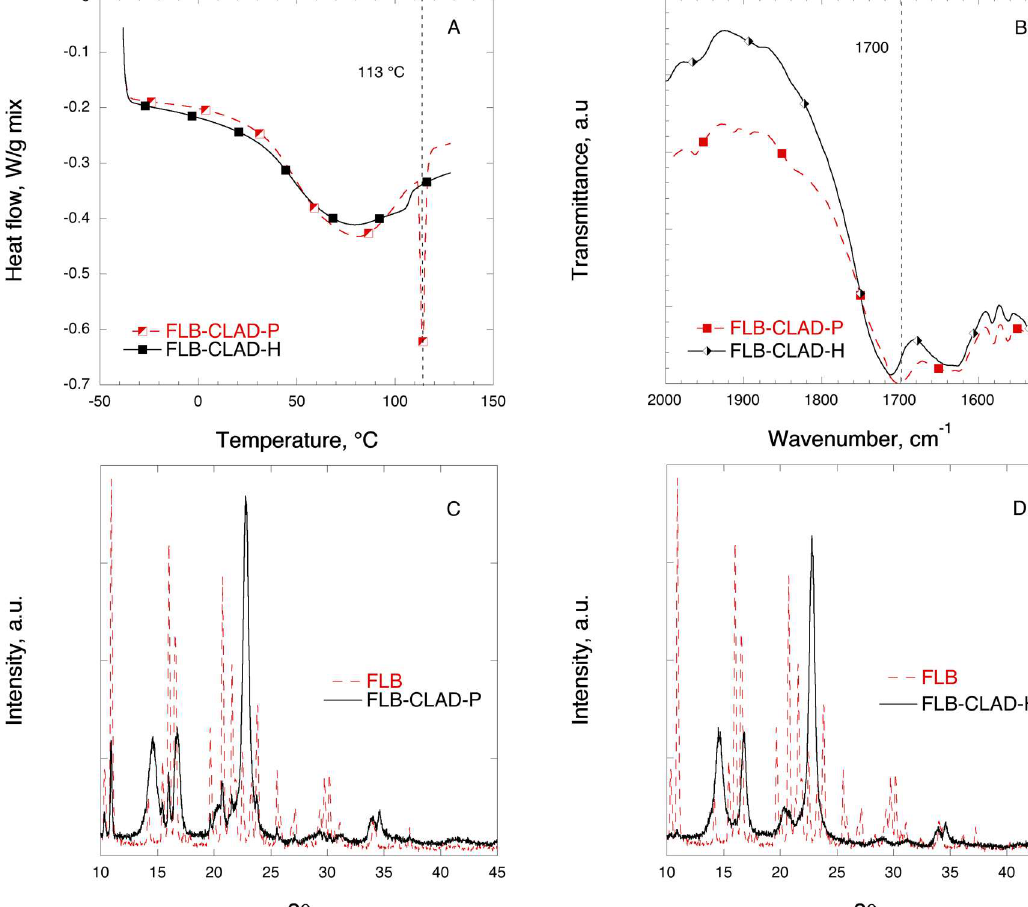
Figure 9. Solid-state analysis of FLB-CLAD 10% w / w mixtures: ( A ) DSC, ( B ) FTIR, ( C ) XRD for P-mixture, and ( D ) XRD for H-mixture. The symbols are only a guide for the eye.